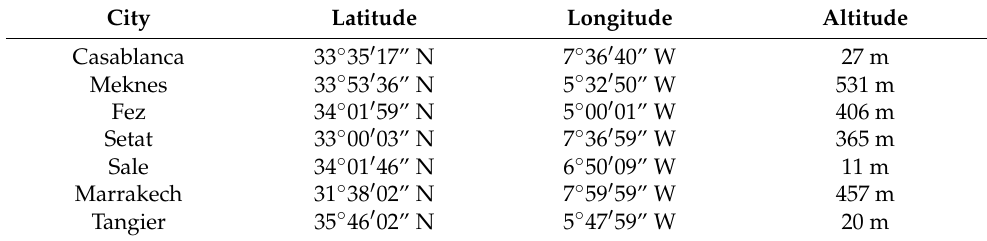
Table 2. The selected